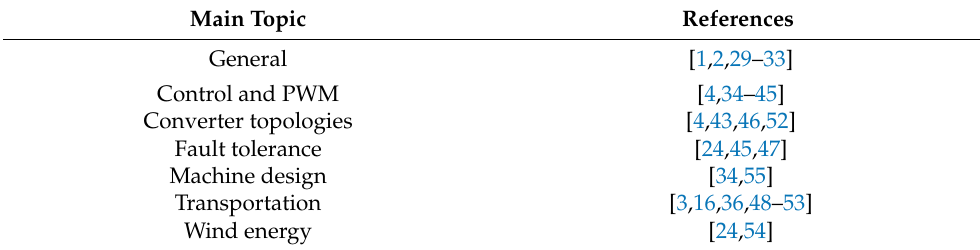
Table 3. Classification of survey papers focused on multiphase